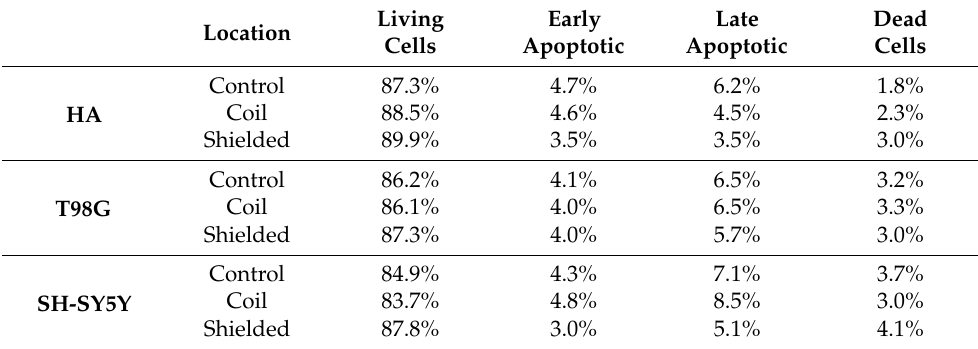
Table 2. The effect of EMF (87 kHz, 30 min) on neural cell death analyzed by flow cytometry. After exposure, cells were regenerated for another 44 h and analyzed by Annexin